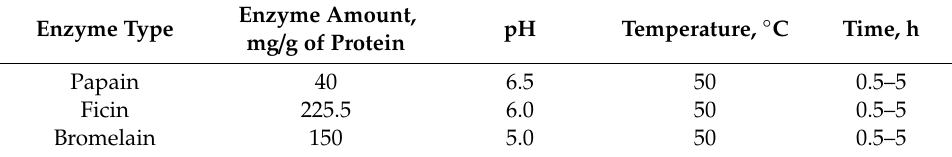
Table 1. Parameters for enzymatic hydrolysis of corn gluten